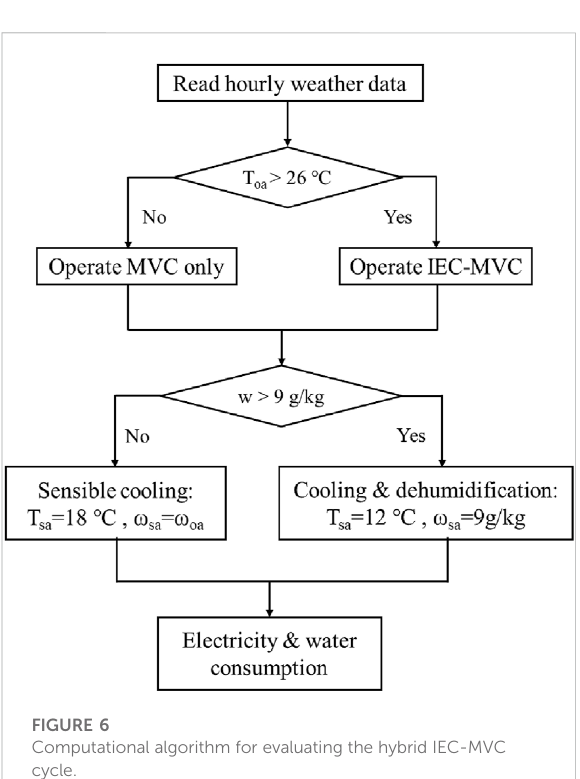
FIGURE 6 Computational algorithm for evaluating the hybrid IEC-MVC